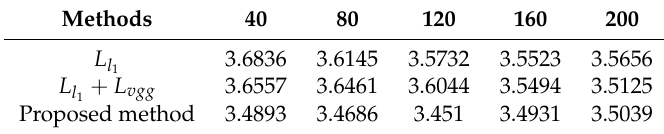
Table 8. NIQE [40] measurement results on the effect of loss